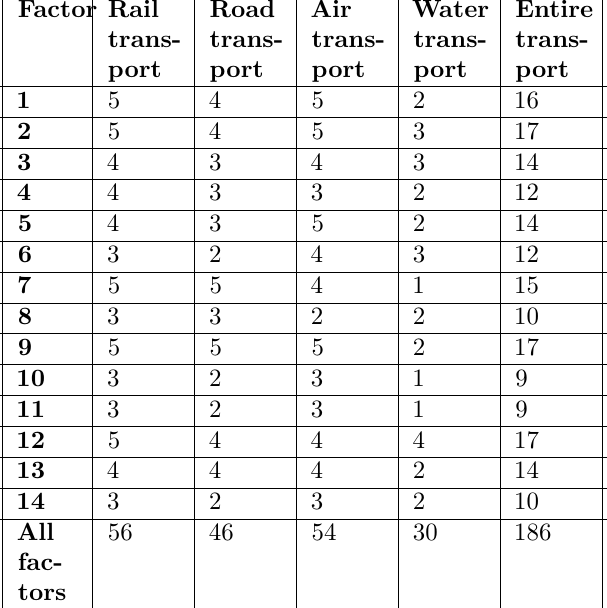
Table 3. Rates of criticality of the transportation infrastructure in the Czech